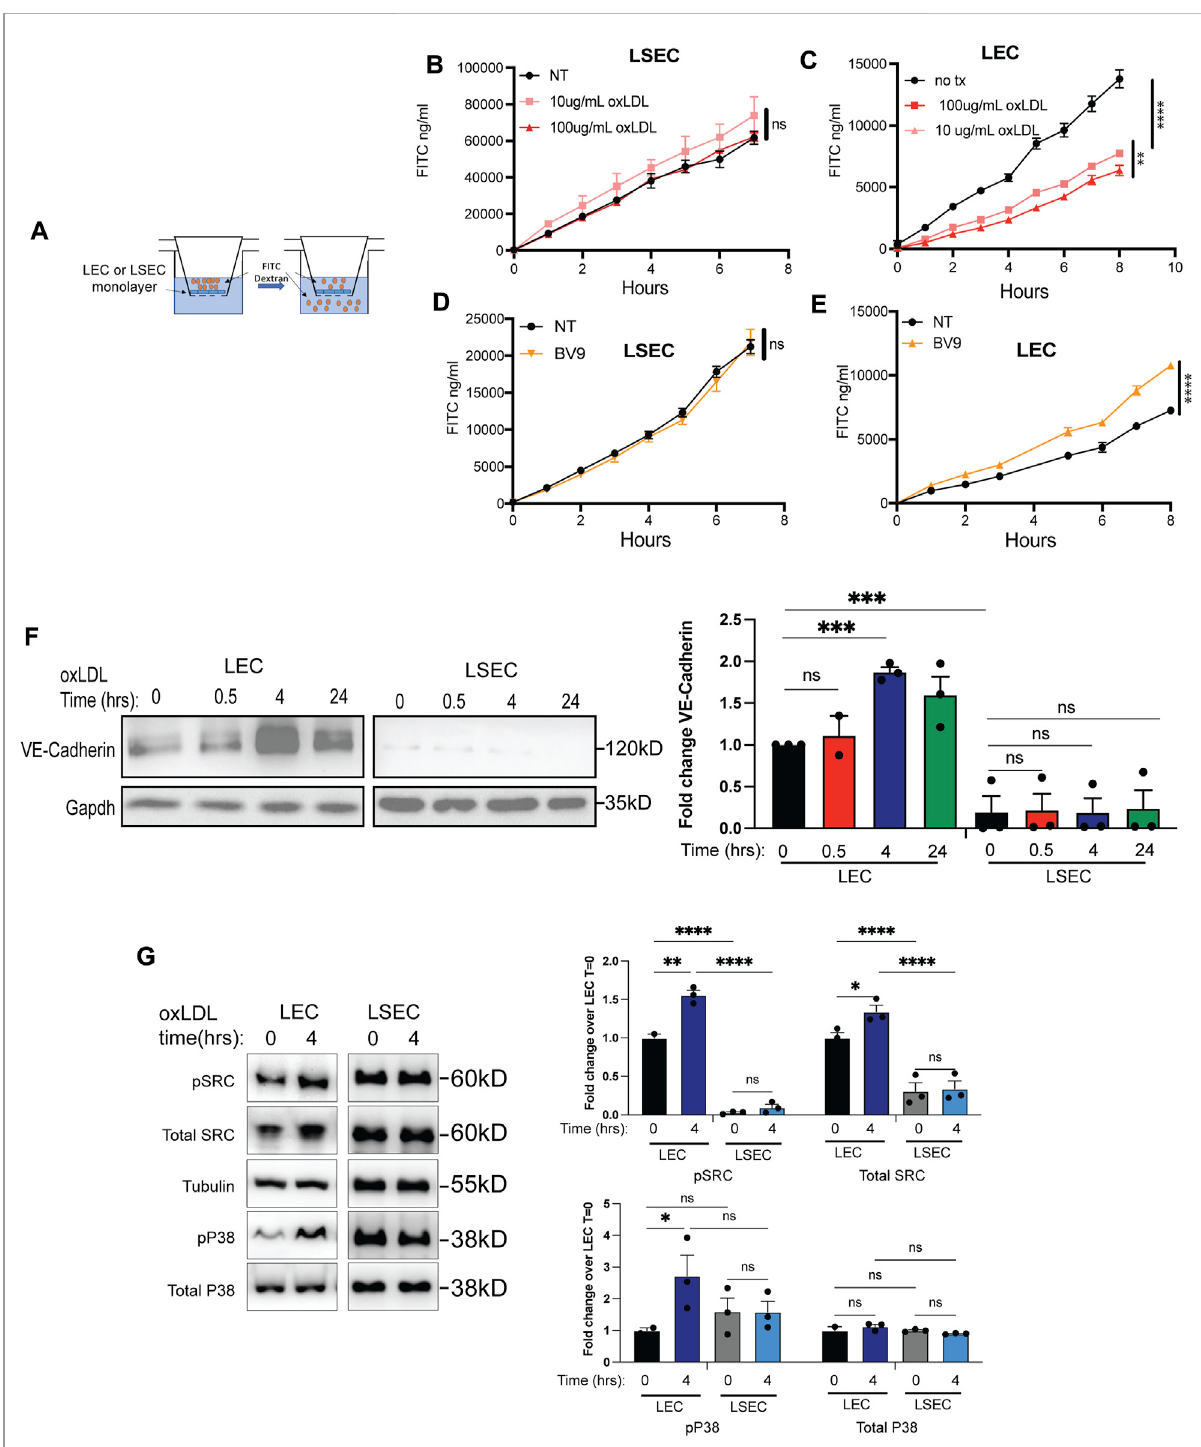
FIGURE 2 oxLDL increases VE-Cadherin surface expression and decreases permeability of lymphatic endothelial cells without affecting liver sinusoidal endothelialcellpermeability. (A) Experimentalmodelof0.4 uMtranswellwithcon fl uentlayerofhumanLECsorLSECsafterallowingthemtogrowto con fl uency. After 3 days, 1.25 mg/ml 500 kDa FITC-dextran added to the top chamber at start of time course and then amount of FITC migrated to bottom chamber measured hourly by fl uorescence. (B) LSECs treated with 4 h of 10 or 100 ug/mL oxLDL in top chamber for 4 h prior